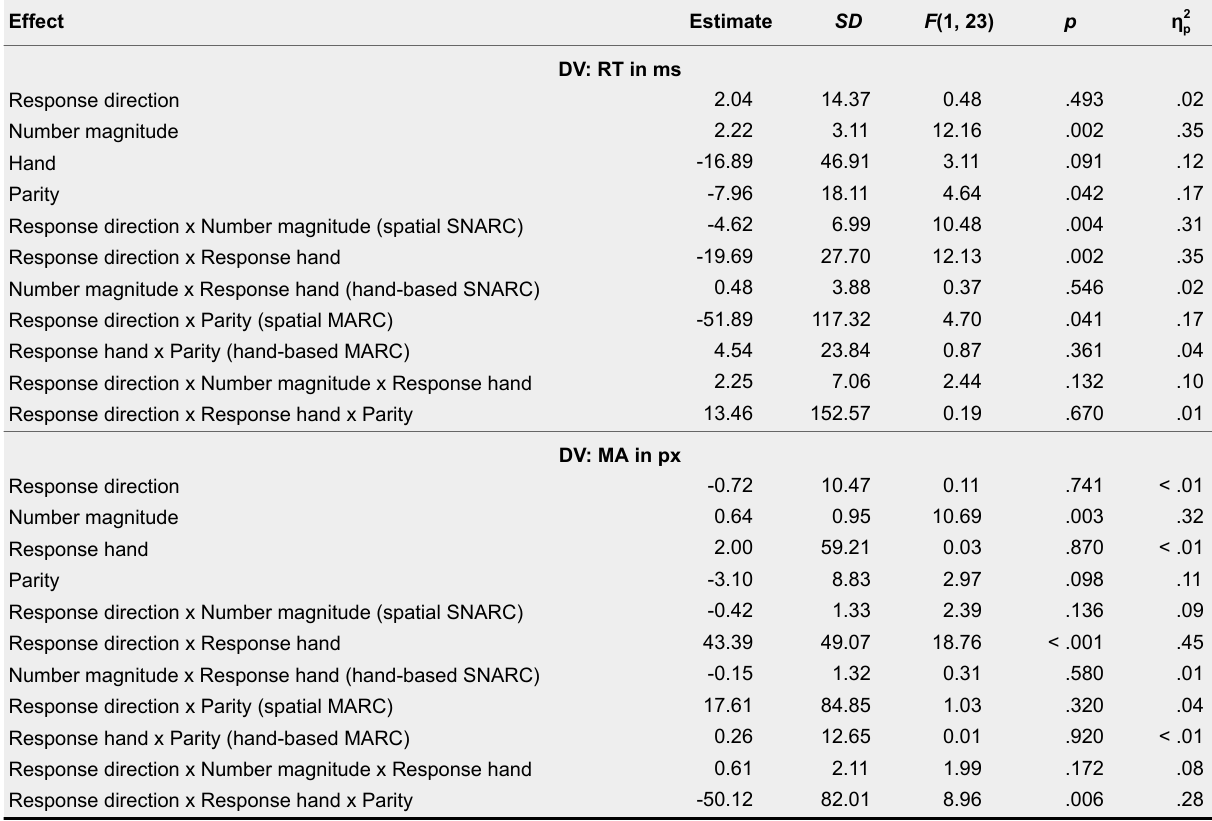
Estimated Effects and Statistics for Dependent Variables of the Parity Judgment